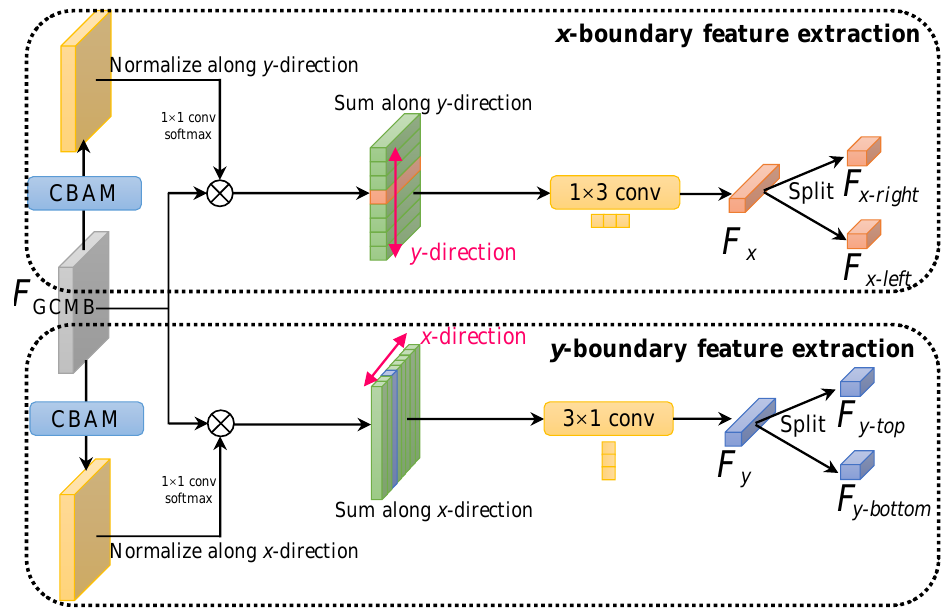
Figure 12. Implementation of the boundary-aware feature extraction (BAFE) used in BABP-Block. Figure 13 shows the implementation of CBAM. Let its input be F GCIM − Block ∈ R H × W × C where H and W are the height and width of feature maps and C is the channel number, then the channel attention is responsible for generating a channel-dimension weight matrix W CA ∈ R 1 × 1 × C to measure the important levels of C channels; the space attention is responsible for generating a space-dimension weight matrix W SA ∈ R H × W × 1 to measure the important levels of space-elements across the entire H × W space. They both range from 0 to 1 by a sigmoid activation which can enrich nonlinearity of neural networks for better performance, suggested by [61]. The result of the channel attention is denoted by F CA = F × W CA . The result of the space attention is denoted by F SA = F CA × W SA . It should be noted that here, the space attention is executed following the channel attention. It is also feasible to change their order.